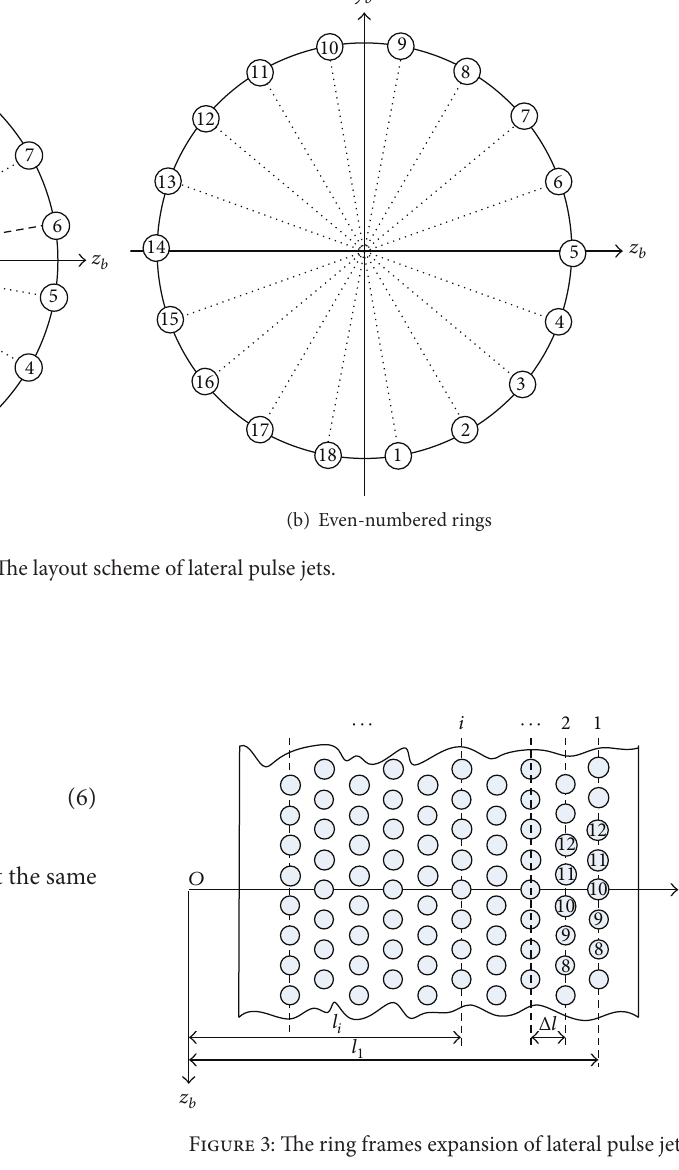
Figure 3: The ring frames expansion of lateral pulse